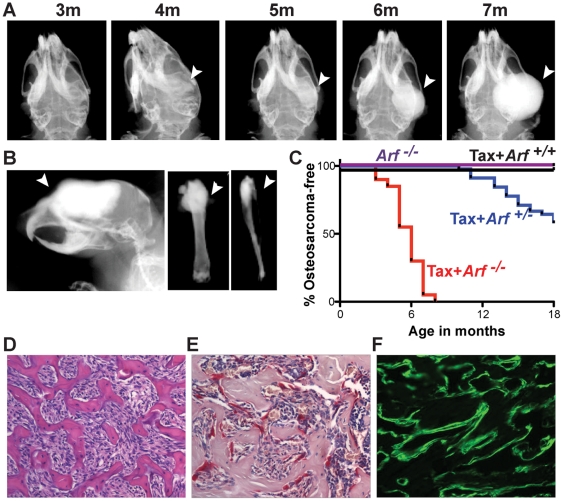
Loss of Arf led to development of high penetrance osteosarcoma in Tax-transgenic mice.a) Serial radiographs of a spontaneous OS on the right jaw of a representative Tax+Arf-/- mouse from 3 months to 7 months of age. b) Radiographs of OS on the skull (right), femur (middle) and tibia (right). c) Kaplan-Meier plot showing OS incidence in Tax+Arf-/- (red), Tax+Arf
+/- (blue), Tax+Arf
+/+ (black) and Arf-/- (purple) mice. Note the decreased incidence and increased latency of OS in Tax+Arf
+/- mice due to loss-of-heterozygosity. Tax+Arf-/- vs. Tax+Arf
+/-, Tax+Arf
+/+ and Arf-/-: p<0.001; Tax+Arf+/- vs. Tax+Arf
+/+ and Arf-/-: p = 0.002 d-f) Characterization of a representative Tax+Arf-/- mandibular OS. d) H&E. Note the trabeculae of bone formed by the OS (bright pink). e) TRAP staining demonstrating osteoclasts (red stained) lining OS bone surface. f) Double calcein labeling, 7d and 2d prior to sacrifice, showing sites of active mineralization.